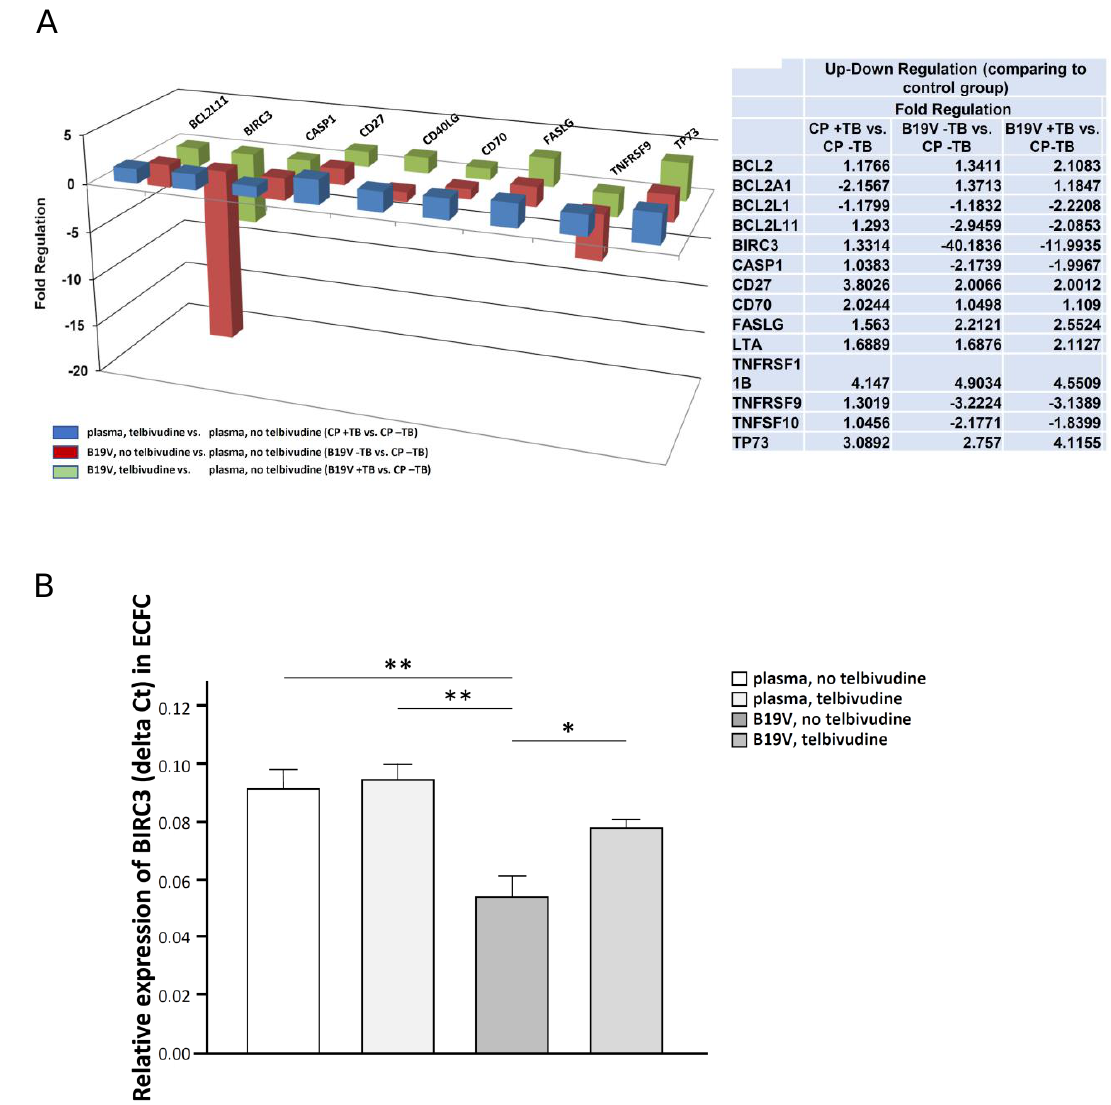
Figure 2. PCR Array for apoptosis and Baculoviral Inhibitor of apoptosis Repeat-Containing protein 3 (BIRC3) after telbivudine pre-treatment in B19V-infected ECFC. ( A ) Regulation of apoptotic genes in ECFC; plasma, telbivudine versus plasma, no telbivudine (blue bars), B19V, no telbivudine versus plasma, no telbivudine (red bars), and B19V, telbivudine versus plasma, no telbivudine (green bars). ( B ) Quantification of BIRC RNA in ECFC, * is p < 0.05, ** is p < 0.01.